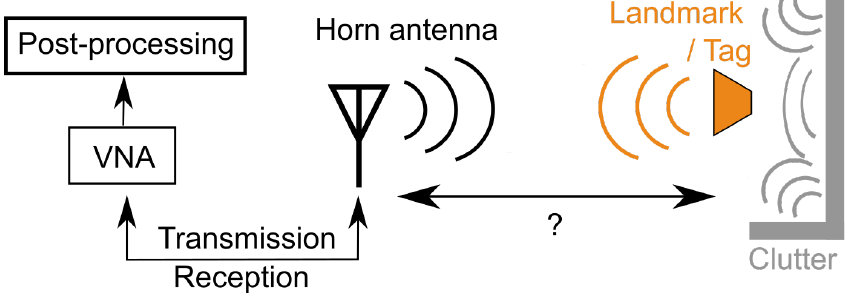
Figure 2. Schematic of the considered mono-static radar